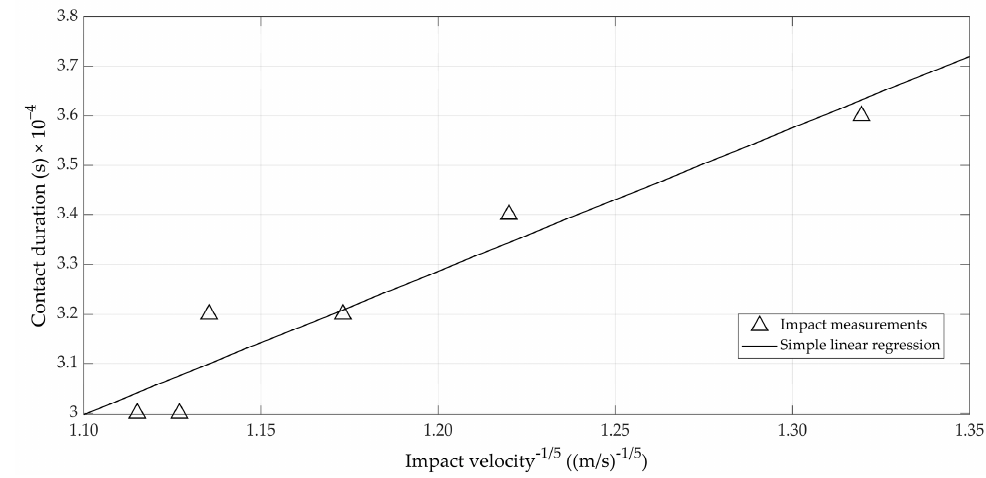
Figure 6. Relation between the impact velocity and the contact duration of the collision.